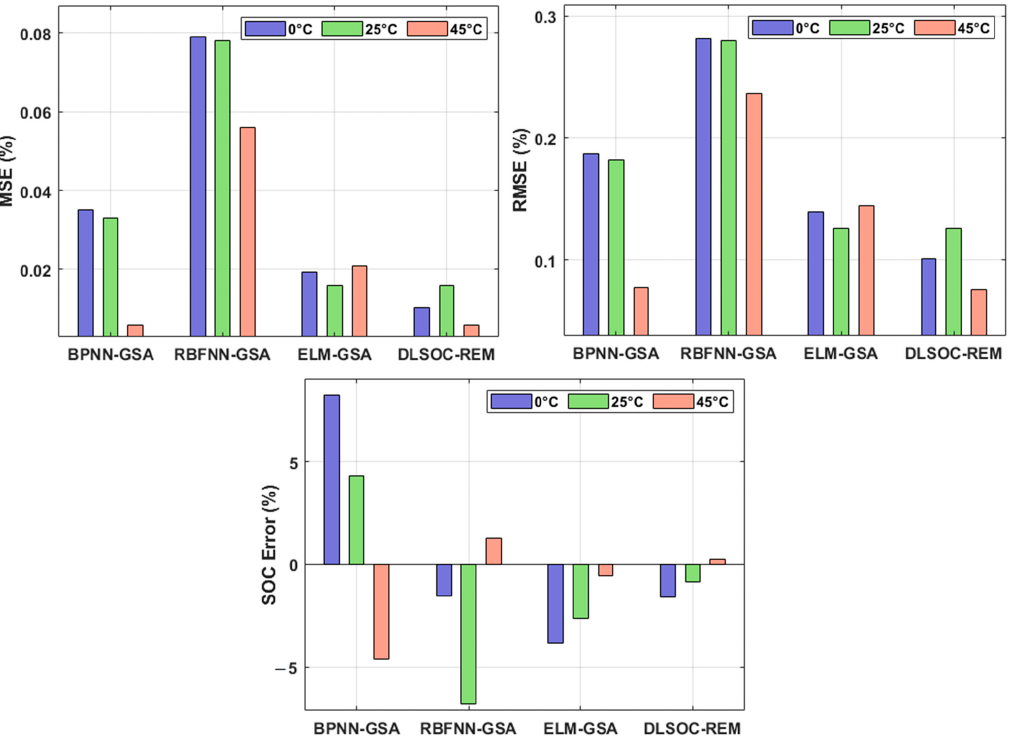
Figure 6. Comparative SOC Estimation analysis of DLSOC-REM technique under FUDS drive cycle.